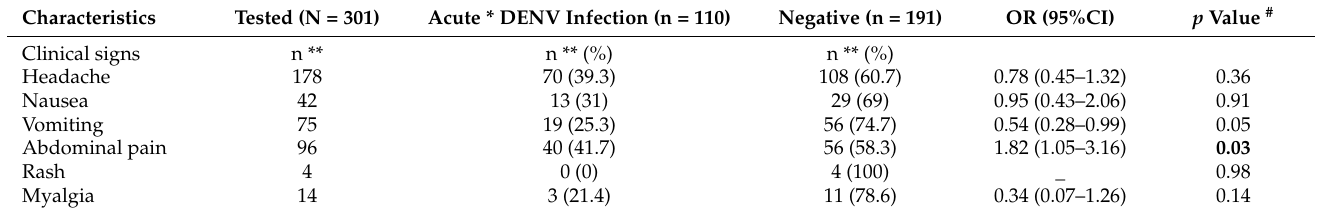
Table 3. Regression analysis assessing the association between clinical symptoms and acute dengue